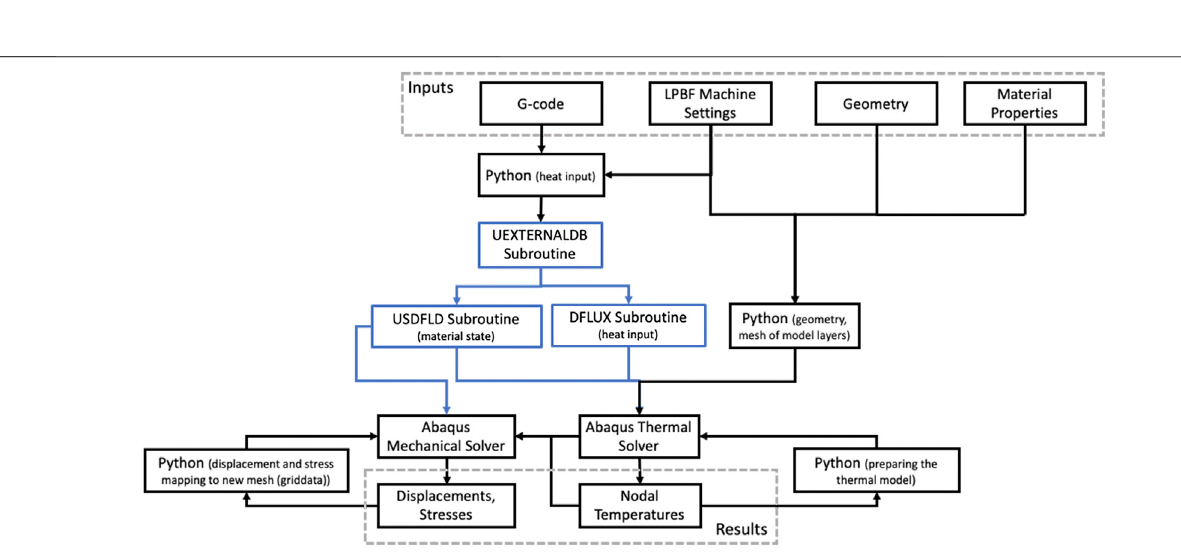
Frontiers in Materials |